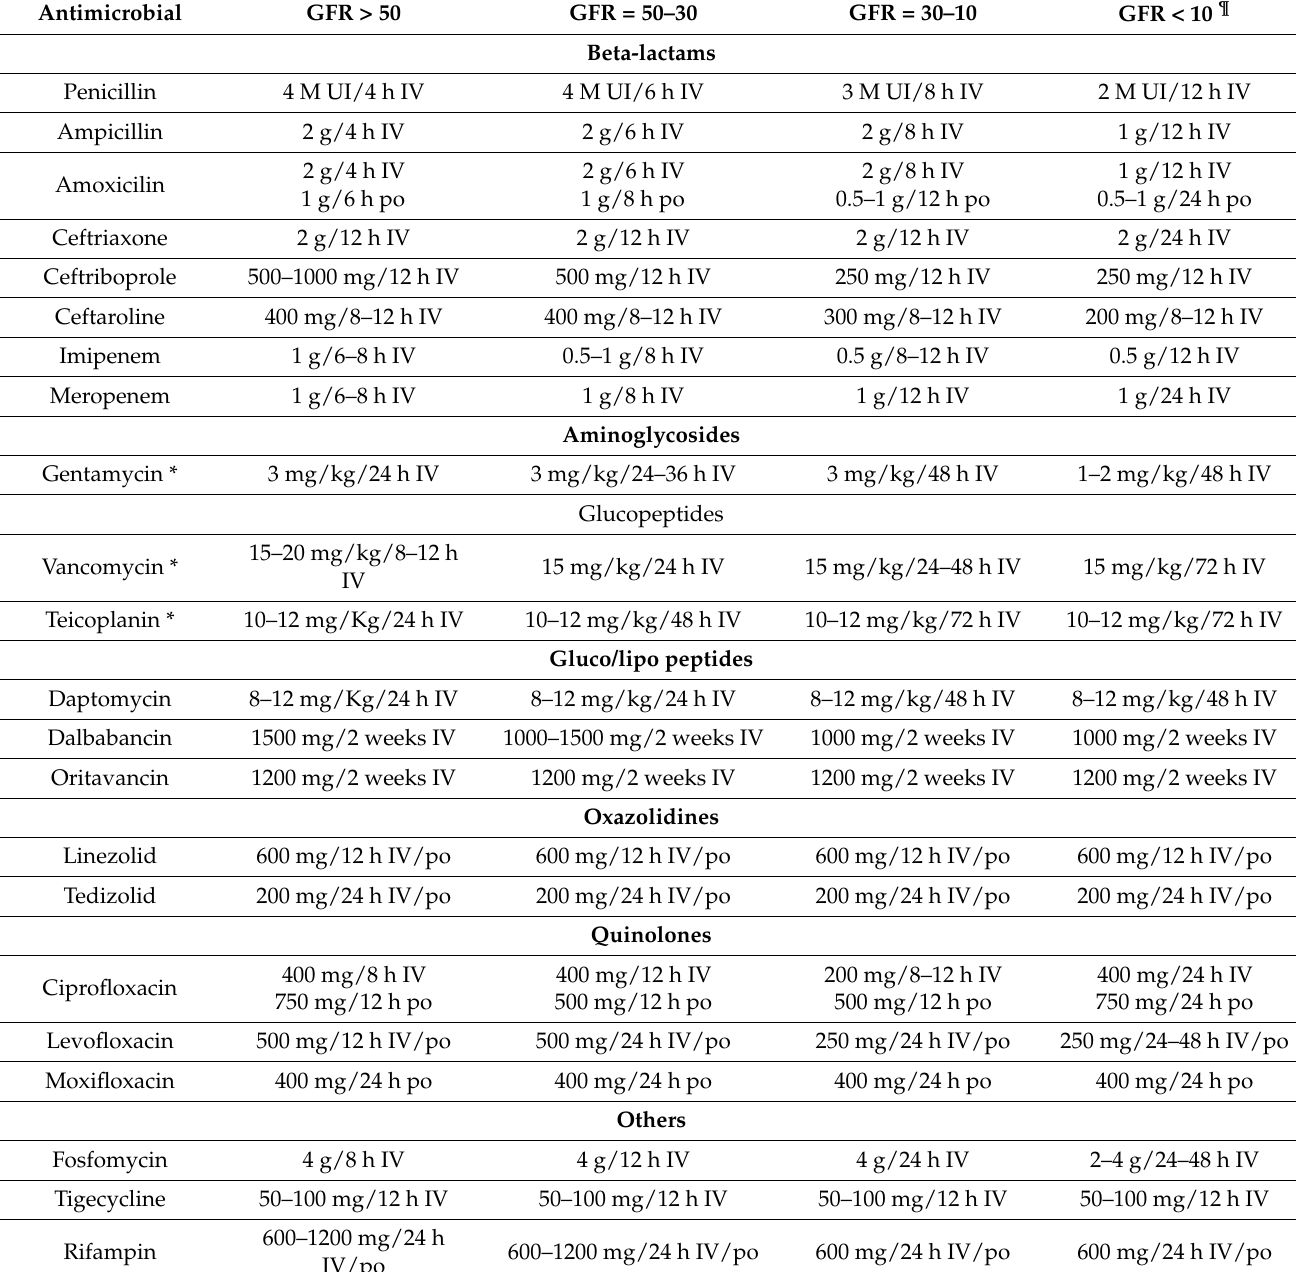
Table 4. Adjustment of antimicrobials according to the Glomerular Filtration Rate (GFR). Doses are provided for the treatment of E. faecalis